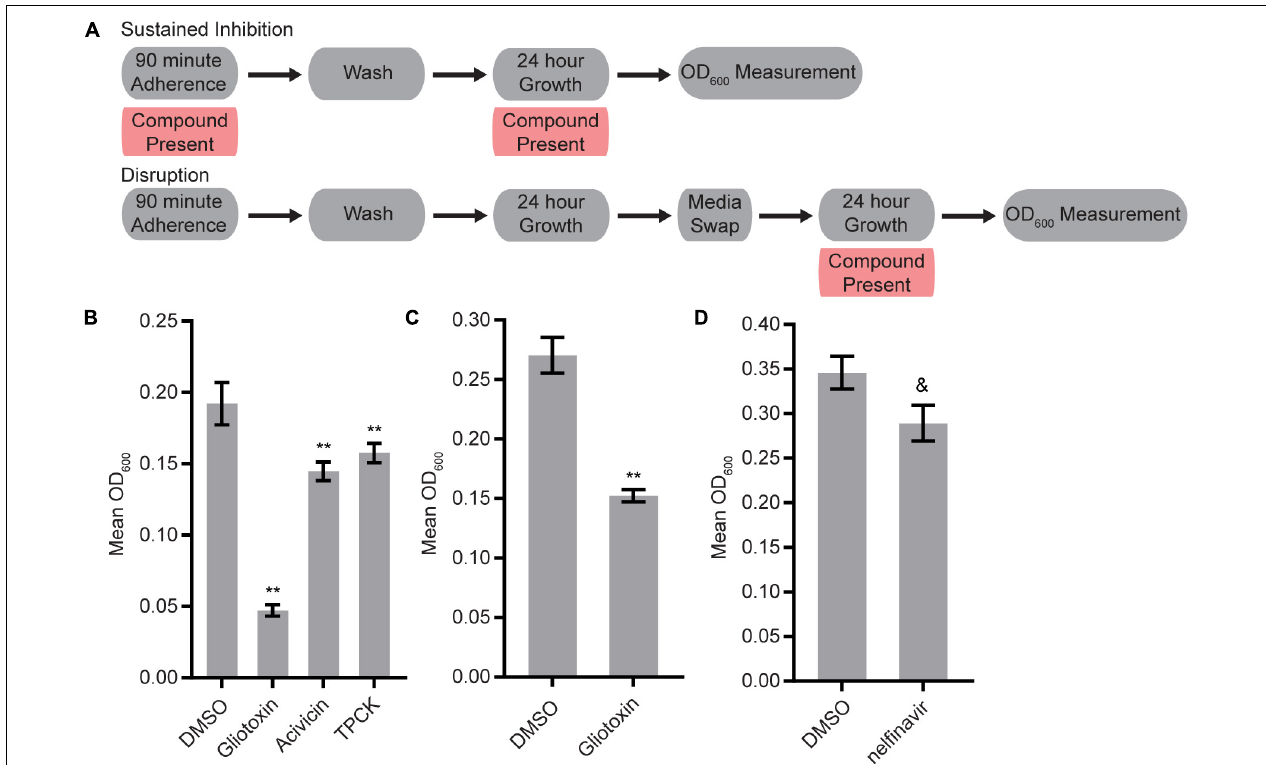
FIGURE 1 | Four protease inhibitors either inhibited biofilm formation or disrupted mature biofilms on their own. (A) Overview of the experimental setups for the Sustained Inhibition and Disruption Biofilm Assays used for these experiments. For the Sustained Inhibition Biofilm Assay, compounds were included during both the 90-min adherence step and the 24-h growth step of a standard biofilm assay. For the Disruption Biofilm Assay, compounds were included during a second 24-h growth step. (B,C) Statistically significant hits from the standalone (B) Sustained Inhibition and (C) Disruption assays with the SCREEN-WELL R (cid:13) Protease Inhibitor Library. Mean OD 600 readings with standard deviations are shown; significant differences from the DMSO solvent control as determined by Welch’s t -test (two-tailed, assuming unequal variance) with the Bonferroni Correction are indicated for α = 0.05 (*) and α = 0.01 (**). Although a single repeat is shown, the indicated threshold was met by all of the repeats of each compound shown. (D) Statistically significant hit from the standalone Sustained Inhibition assays with the two aspartyl protease inhibitor libraries. Mean OD 600 readings with standard deviations are shown; significant differences from the DMSO solvent control as determined by Welch’s t -test (two-tailed, assuming unequal variance) with the Bonferroni Correction are indicated. A single repeat is shown; the indicated significance threshold was met by two of the three repeats at α = 0.01 while the third repeat did not pass at α = 0.05. The “&” symbol indicates this mixed